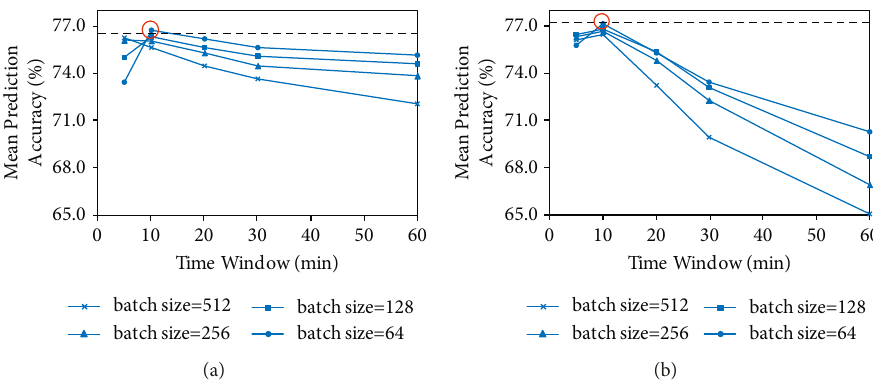
Figure 7: Parameter tuning and sensitivity analysis. (a) GRU. (b) Bi-GRU-Attention.